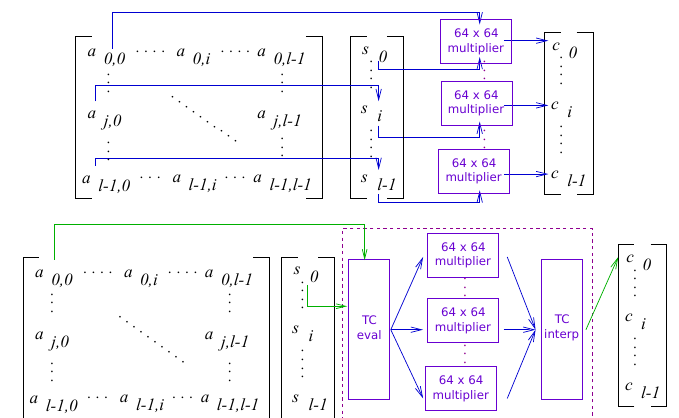
Figure 1: Comparison of parallel polynomial multiplication in Espada (top) with poly- nomial multiplication in Saber (bottom). The lines in blue and green denotes parallel and serial execution respectively. The components inside the boxes are implemented on